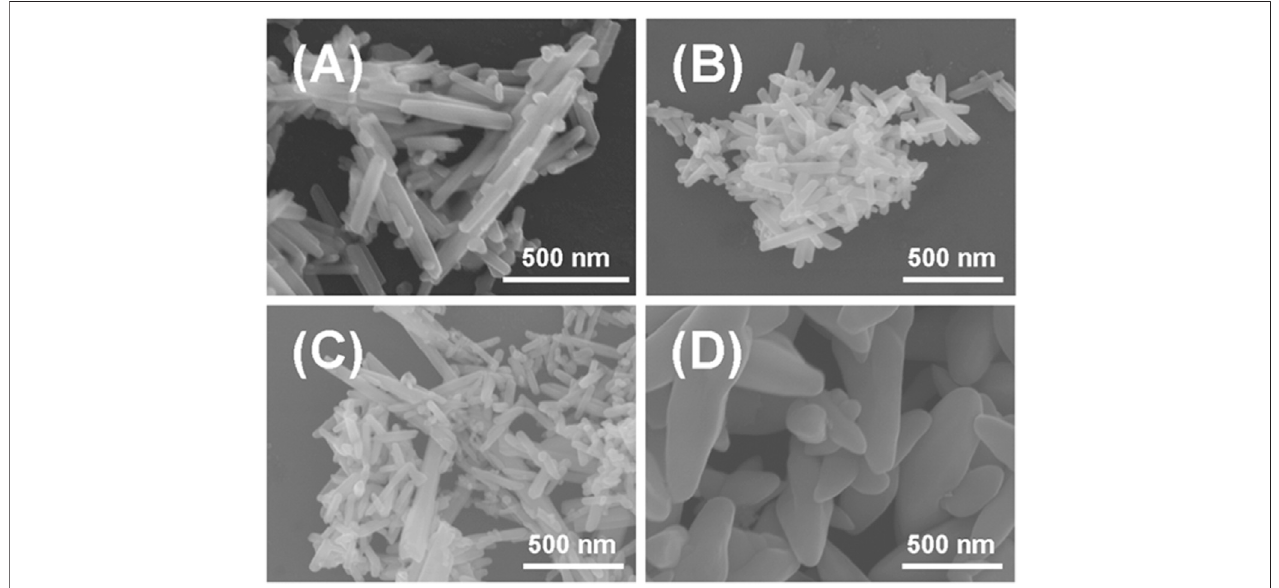
FIGURE 1 | SEM image of solid products prepared by electrochemical cyclic voltammetry with different types of precursor S sources and the same concentration of 0.5 mol L − 1 : (A) Te@C 3 H 6 NNaS 2 , (B) Te@CH 4 N 2 S, (C) Te@NaHS, (D) Te@Na 2 S.